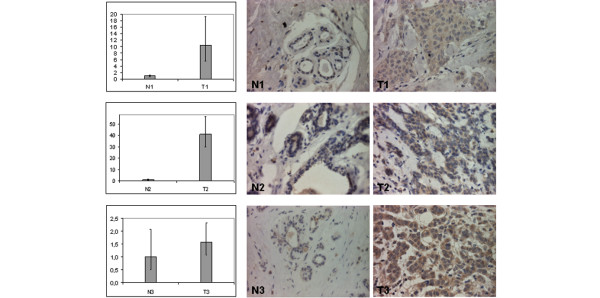
Correlation between ISG15 mRNA and protein expression. An additional collection of paraffin-embedded breast carcinomas (T; n = 10) and corresponding normal breast tissues (N; n = 10) was analysed for ISG15 expression by semiquantitative real-time PCR and immunohistochemistry in the same samples. ISG15 mRNA upregulation correlated with ISG15 protein expression in the same tumour sample (T) compared with the corresponding normal breast tissue (N). Magnification: 400×.